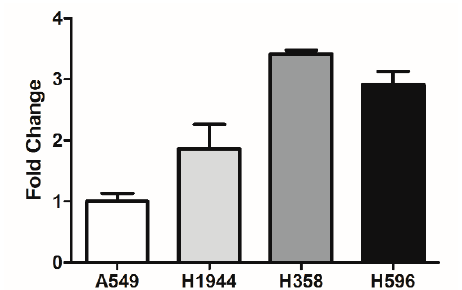
Figure 1. Analysis of basal HOTAIR gene expression levels in NSCLC cells by